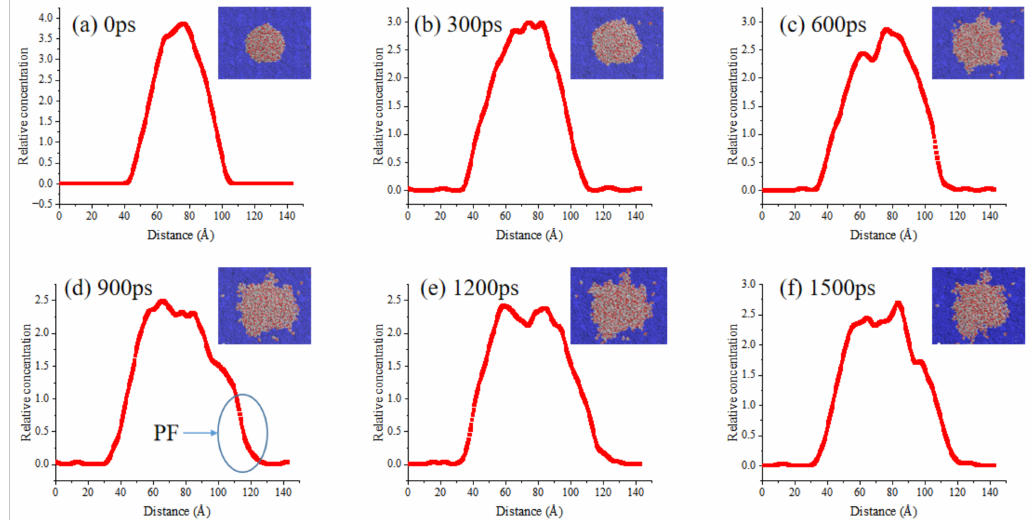
Figure 13. Side and top views of SLRO droplet structure evolution. Note: blue block represents bitumen subgrade, red line represents SLRO droplet concentration